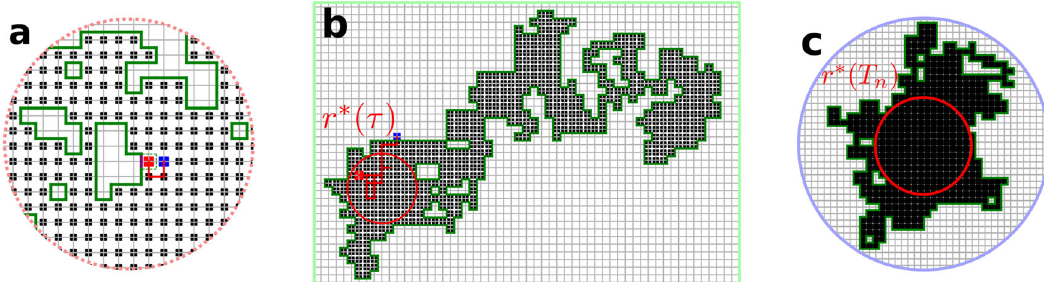
Fig. 2 | The threetemporal regimes ofthe explorationdynamics,asillustrated by a RW on a square lattice. Each panel shows the corresponding different con- trolling con fi gurations when n =500 distinct sites have been visited. The n th and ( n +1) st visitedsiteareshowninredandblue,respectively( a and b ). a Earlytime:the visited domain (black squares within the green boundary) is effectively in fi